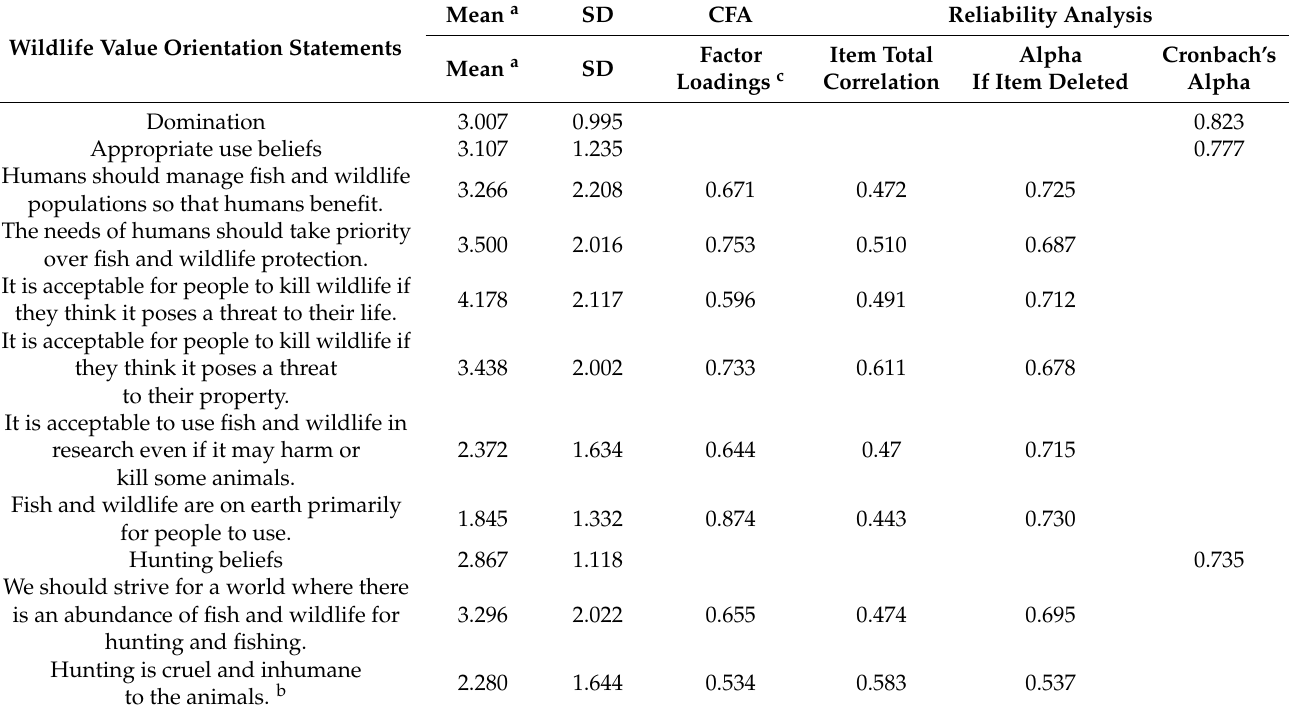
Table 2. Reliability and confirmatory factor analysis (CFA) of wildlife value orientation